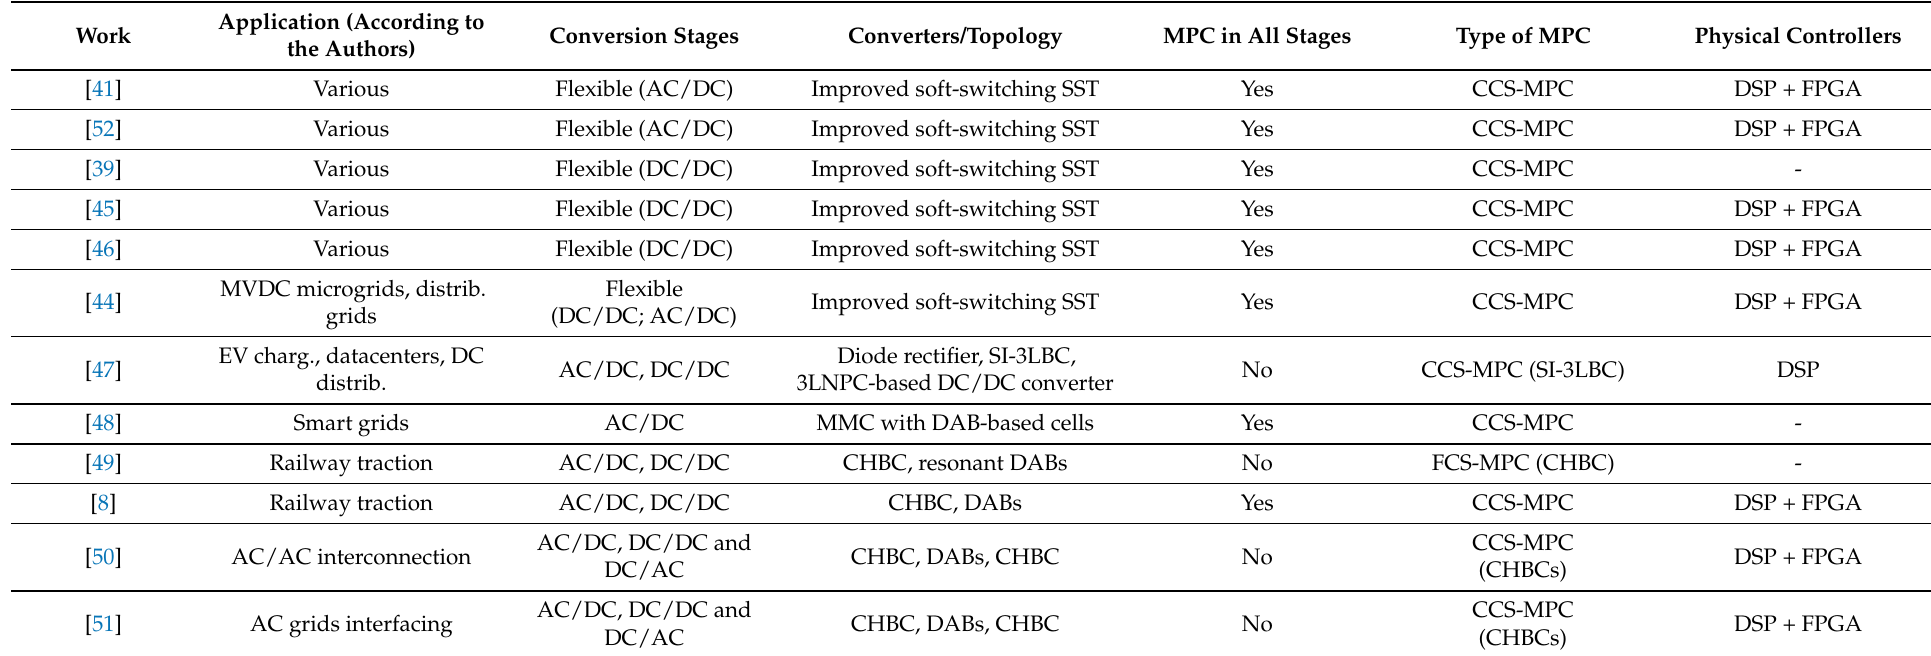
Table 2. MPC strategies in modular SST